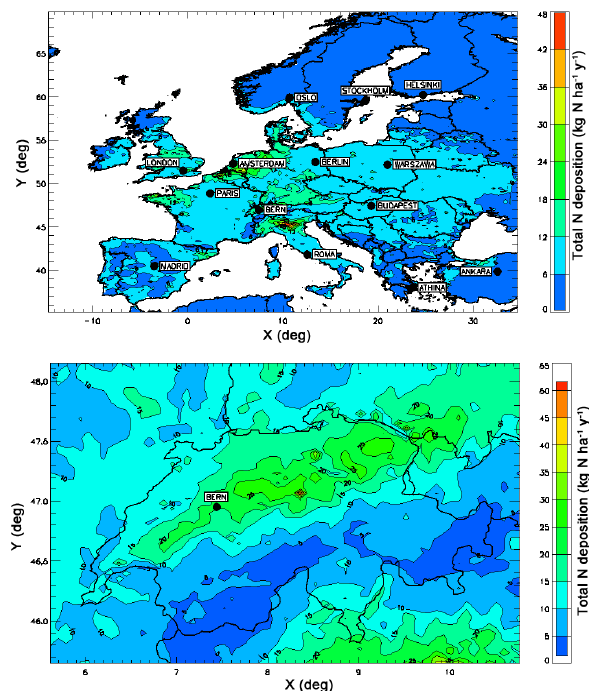
Figure 13. Total N deposition (kgNha − 1 yr − 1 ) over the European (upper panel) and Swiss (lower panel) domains (2006).